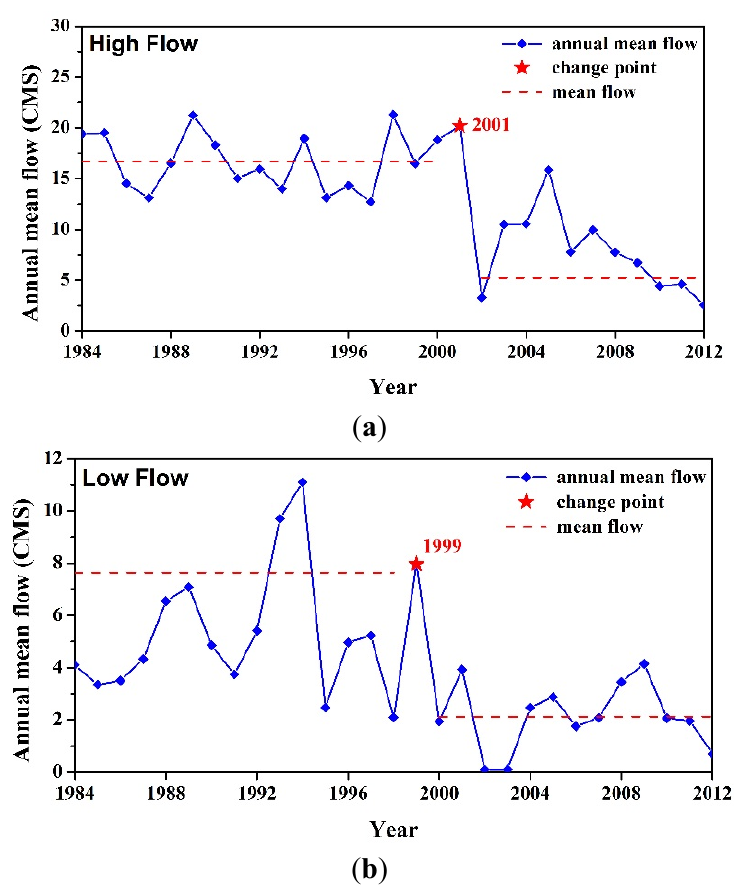
Figure 6. Results for the change points in the high and low flows: ( a ) high flow; ( b ) low